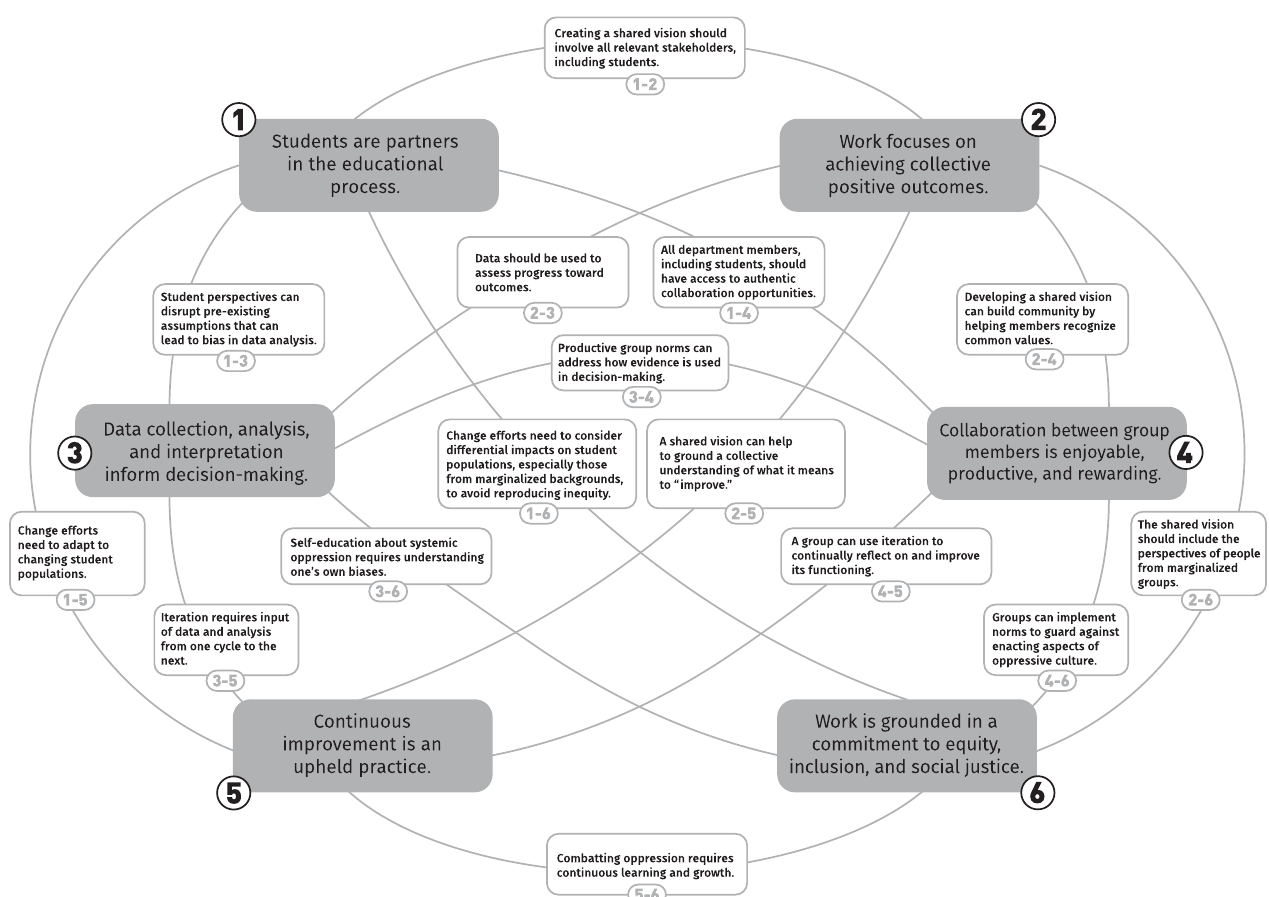
FIG. 1. An illustration of each principle (gray boxes) and the connections between them (white boxes with black